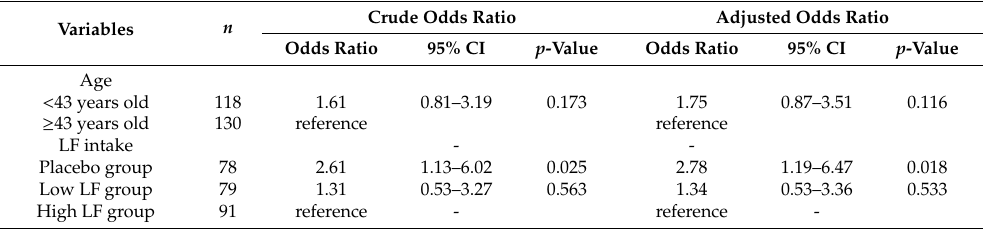
Adjusted odds ratio: Adjusted for age and LF